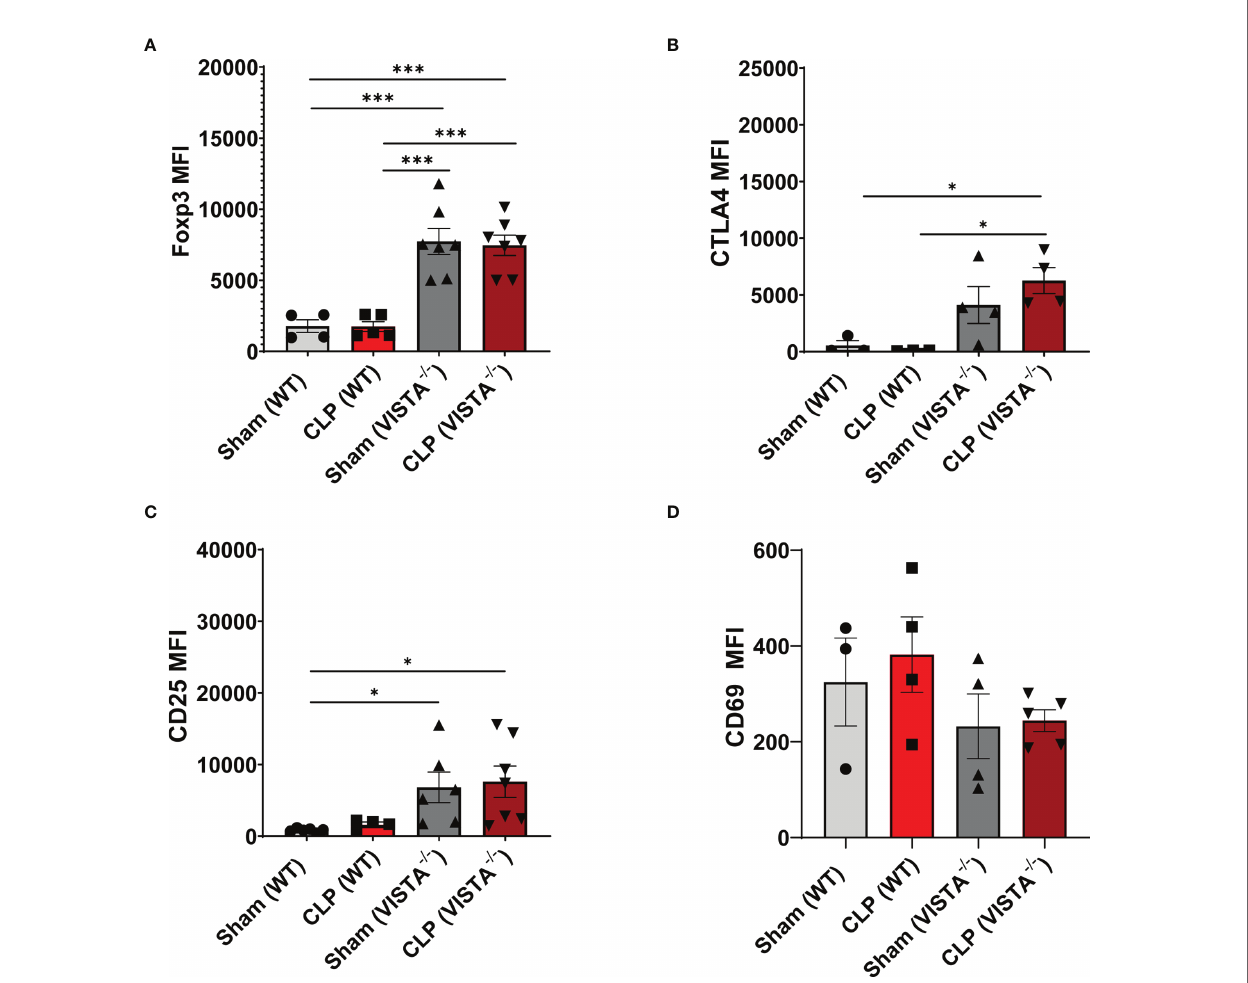
FIGURE 5 | Expression of suppressive markers is upregulated on CD4 + T regs in the spleen of VISTA -/- mice. Median fl uorescence intensity (MFI) of (A) Foxp3, (B) CTLA4, (C) CD25, and (D) CD69 on CD4 + T regs in the spleen. Summary graphs show mean ± SEM [WT-sham: n = 3 , WT-CLP: n = 3 , VISTA -/- sham: n = 4 , VISTA -/- -CLP: n = 4 ]; signi fi cance *p < 0.05; ***p <